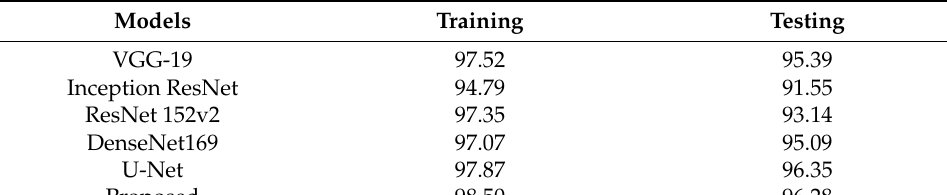
Table 5. Comparative analysis of F-measure of the proposed model with traditional models.